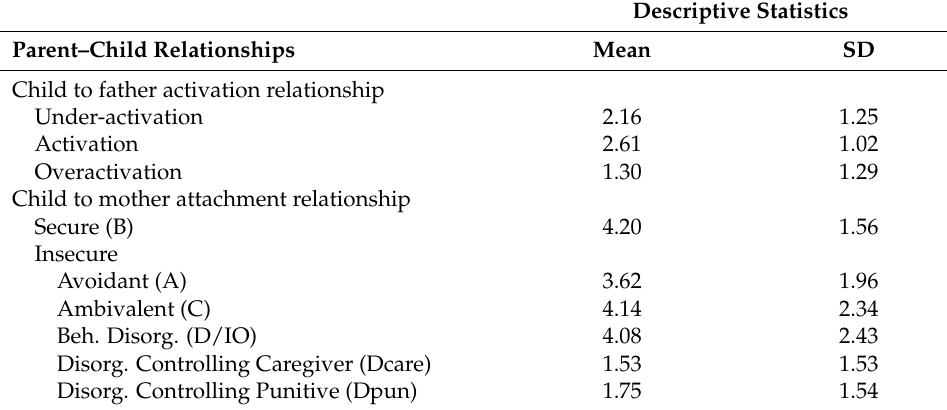
Table 2. Mean scores and standard deviations (SD) for child activation to father scales and child attachment to mother